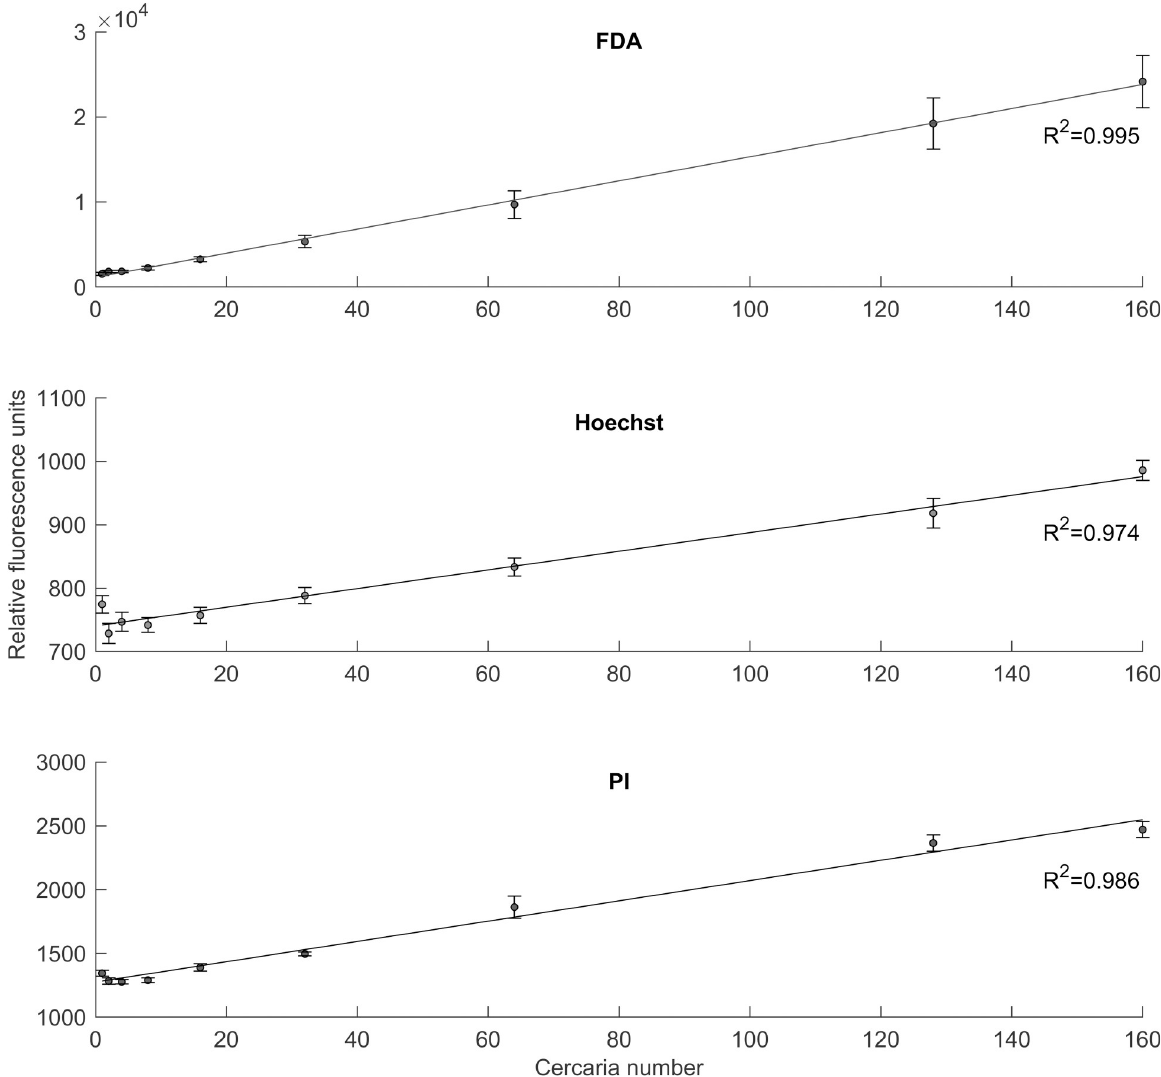
Fig 5. Fluorescence compared against cercaria number for the dyes considered in this study. Live (FDA) and dead (PI and Hoechst) cercariae were serially diluted from 128 to 1 cercaria/well, with an additional well containing 160 cercariae. Fluorescence measurements were taken at 20 minutes. Data points and error bars show the mean and SEM of nine wells (experiments run in triplicate and repeated three